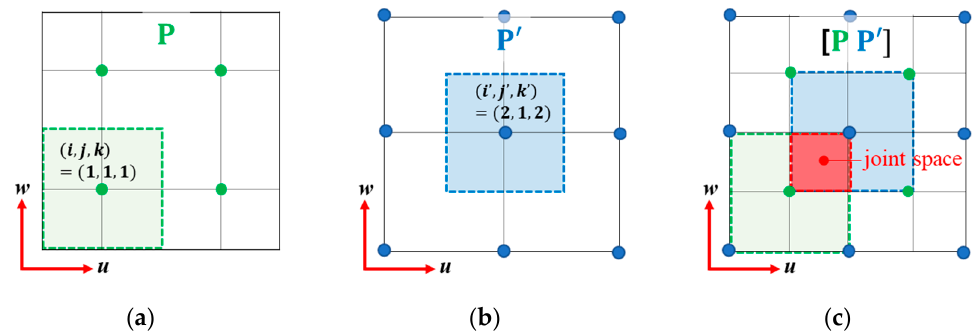
Figure 2. The u–w plane in the search space including two different grid sets. ( a ) ( i, j, k )th grid point among the first grid set, and corresponding bound (marked with dashed line) and volume space (marked with colored square). ( b ) ( i’, j’, k’ )th grid point among the second grid set, and corresponding bound (marked with dashed line) and subspace (marked with colored square). ( c ) Joint space induced by the ( i, j, k )th and the ( i’, j’, k’ )th grid points.